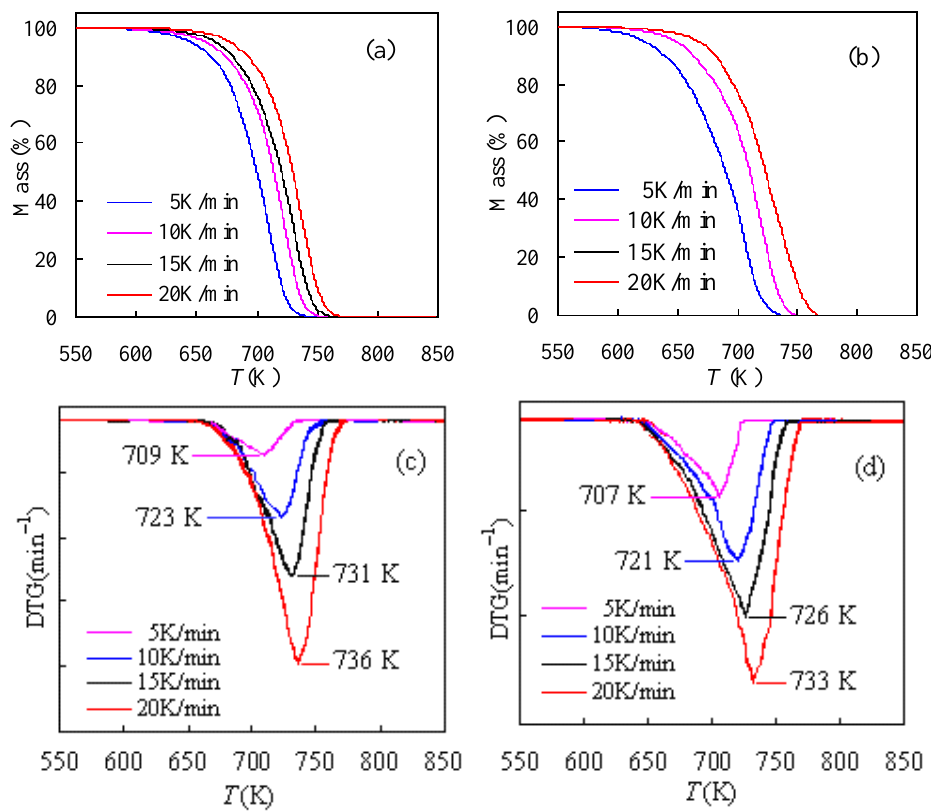
Figure 2. TG ( a , b ) and DTG ( c , d ) results of tennis string nylon samples measured in the atmosphere of inert N 2 ( a , c ) and oxidative air ( b , d ).